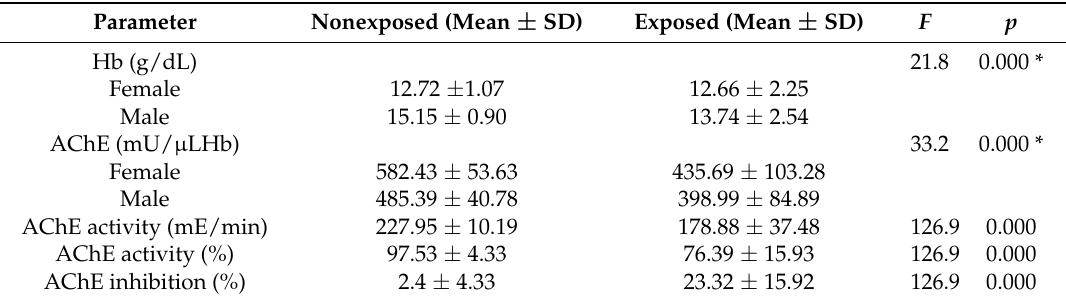
Table 2. Acethylcholinestease activity data of the general study population. The p -values for each parameter were obtained by factorial ANOVA, and p < 0.05 was considered statistically